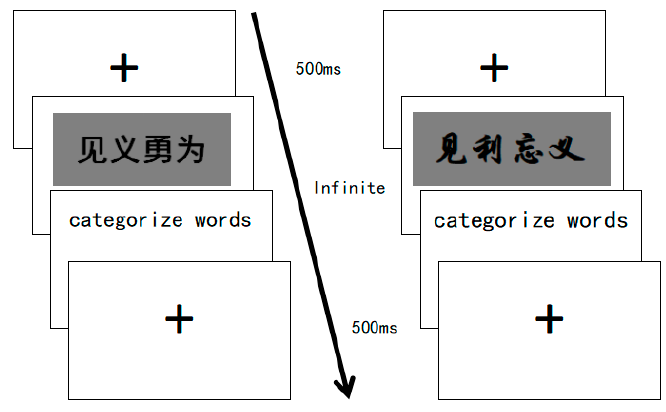
Figure 1. The experimental procedure for Experiment